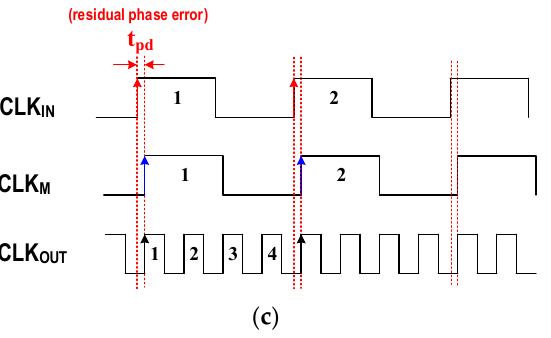
Figure 2. ( a ) Block diagram of a general MDLL with a front divider M and a feedback divider N to generate N/M times output frequency. ( b ) Locking process when N/M = 4/1 (assuming t pd = 0). ( c ) Residual phase error (or offset) problem when t pd ≠ 0.